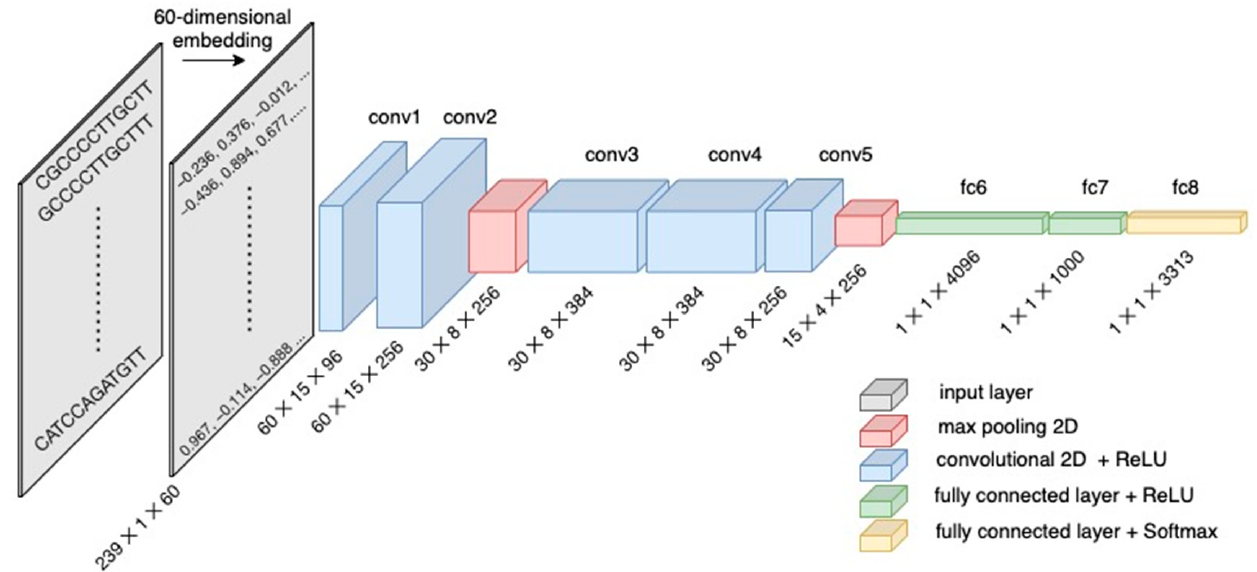
Figure 2. Convolutional neural network architecture used to build the taxonomic read classifier DL-TODA. Each read is represented as an input layer (239 × 1 × 60) by embedding 12-mers into vectors of 60 real values. The input layer is then processed by five convolutional layers, two max pooling layers and three fully connected layers.